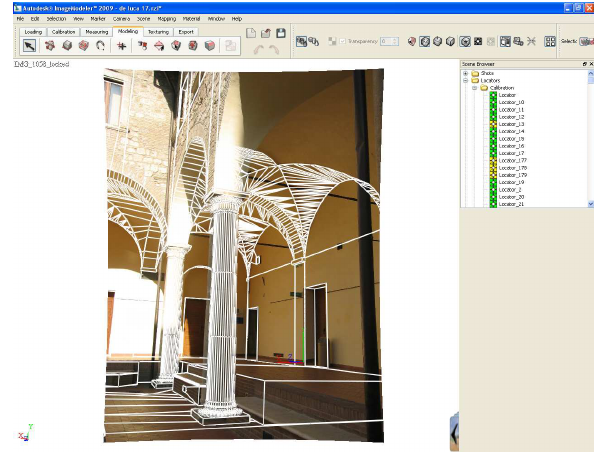
Figure 10. Cloister of Annunziata: octagonal column